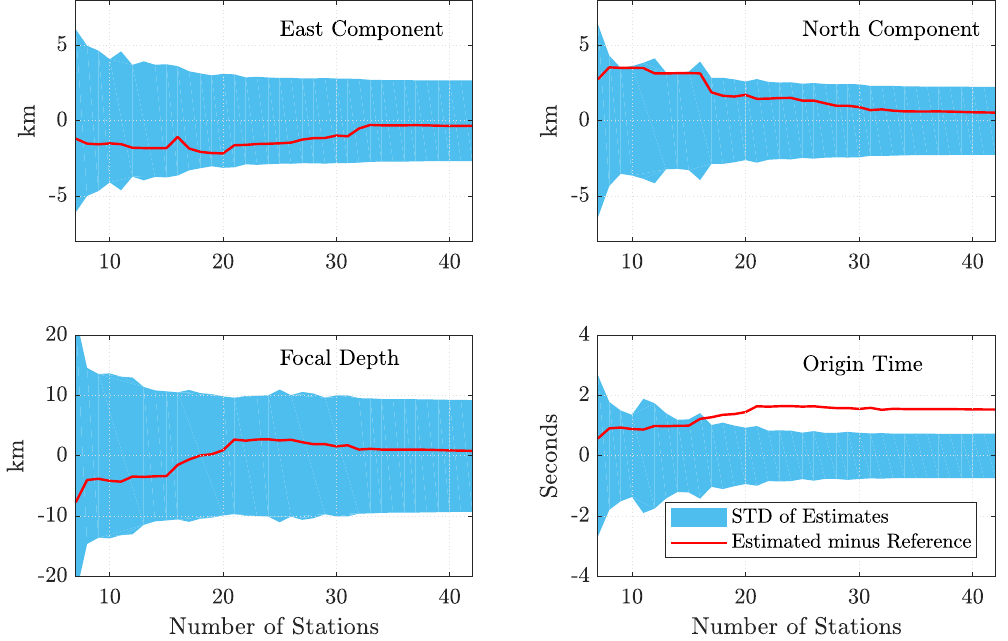
Figure 6. Differences of the estimated earthquake hypocenter from the GNSS arrivals with regard to to the reference hypocenter coordinates (for the East, North, and Depth components), as well as the differences of the estimated origin time with regard to the reference. Overall, the co-ordinates obtained for the hypocenter agree within 1–2 km of the reference solution, and better than one kilometer for the final estimates including all 42